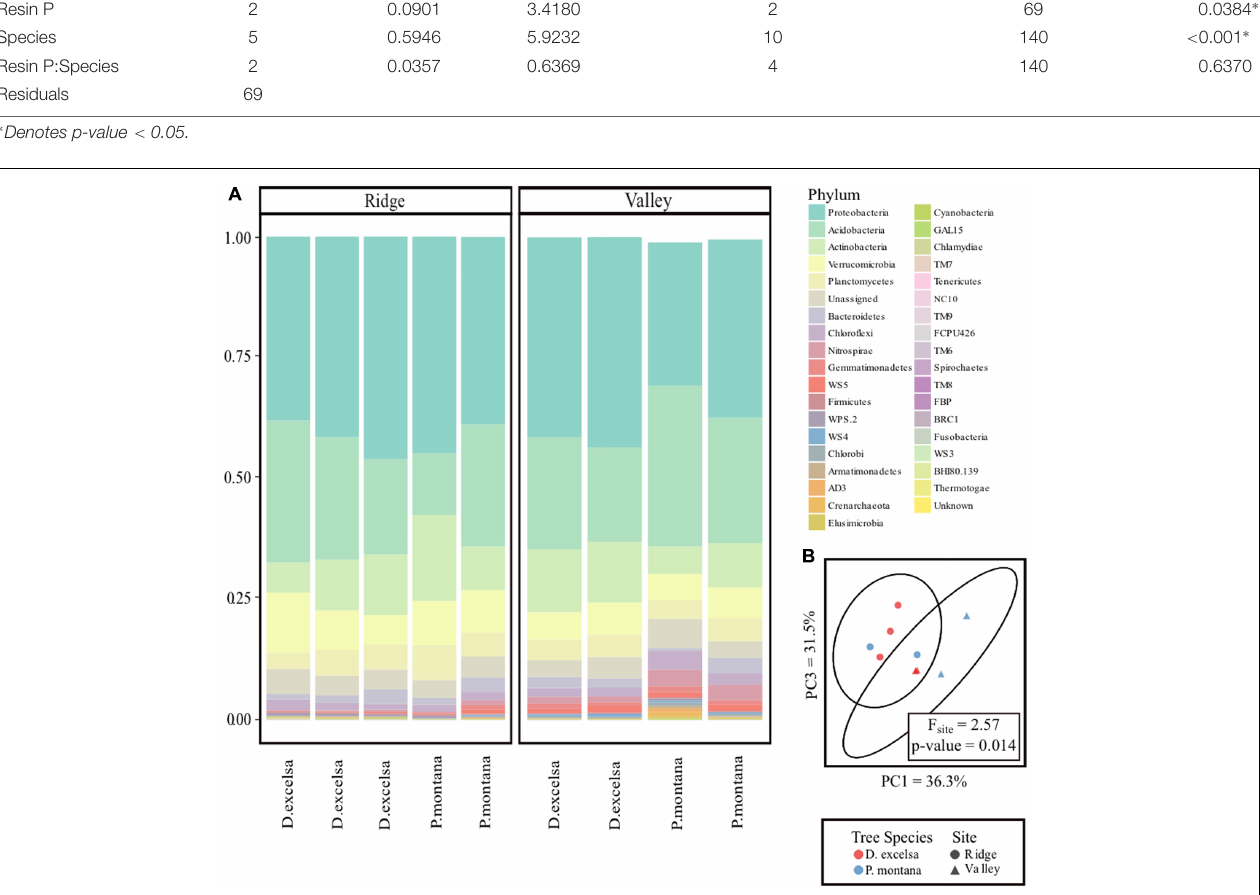
FIGURE 3 | Comparison of bacterial communities between Ridge and Valley sites and D. excelsa and P. montana . Relative abundance plot of bacterial phyla > 2% of the community (A) . One P. montana sample in the Valley contained multiple phyla each representing < 2% of the community. These were excluded from the plot resulting in a shorter bar. PCoA with ellipsoids representing 95% confidence intervals (B) .